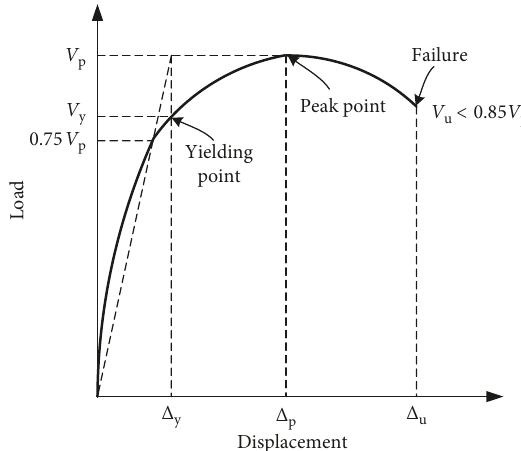
Figure 19: The definition of the yielding